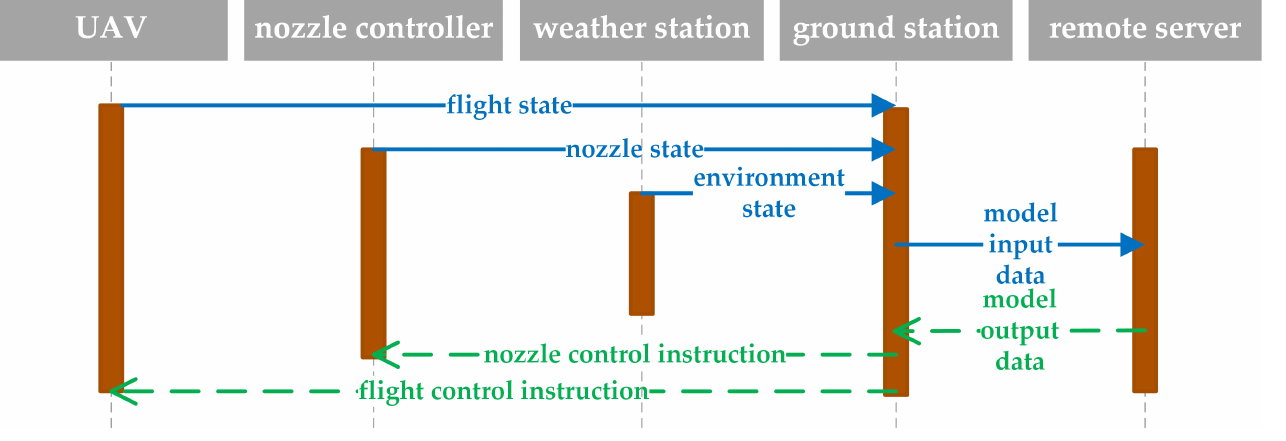
Figure 12. Sequence diagram of variable spray